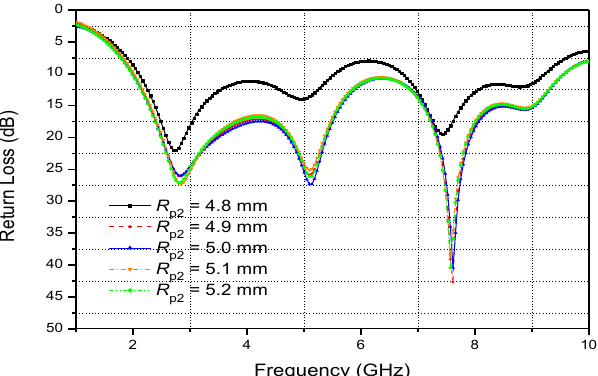
Figure 4: Simulated return loss against frequency for the octagonal ring shape ultra wideband antenna with various : other parameters are the same as listed in Table R p2